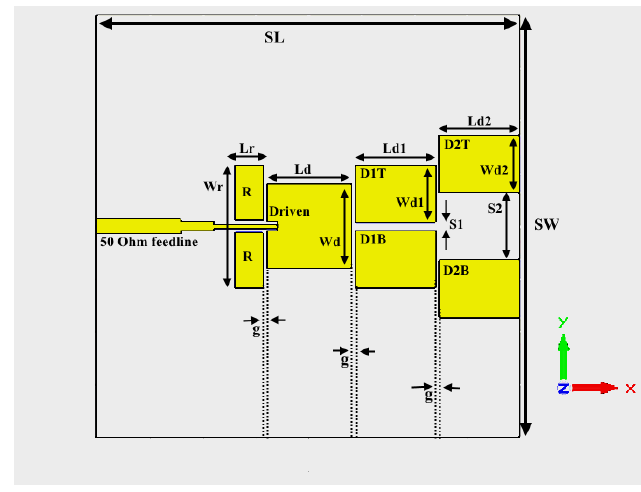
Figure 3. Schematic view of antenna design.